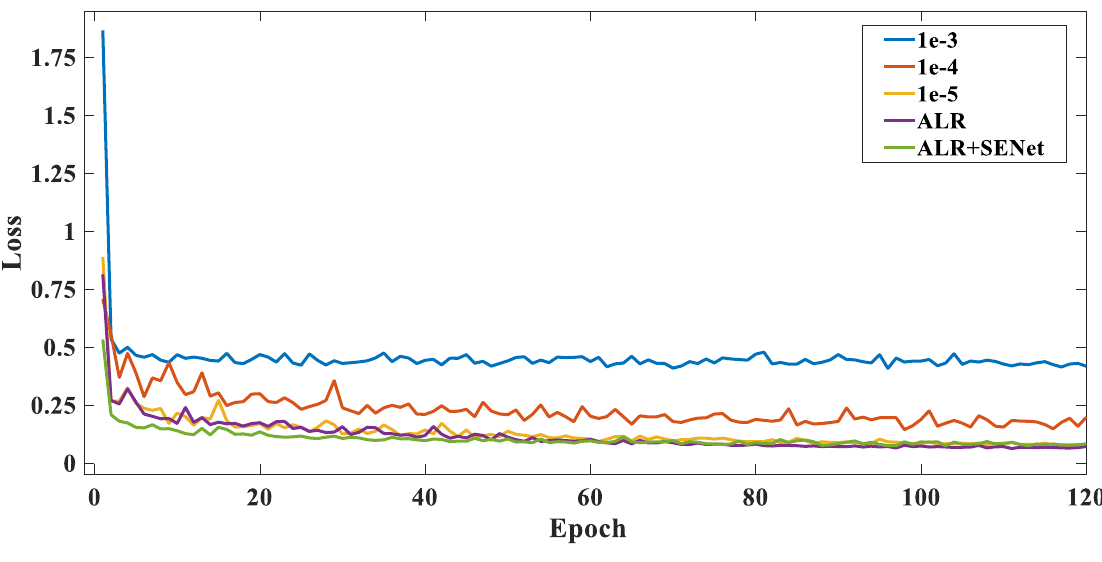
Figure 6. Training loss value curve.